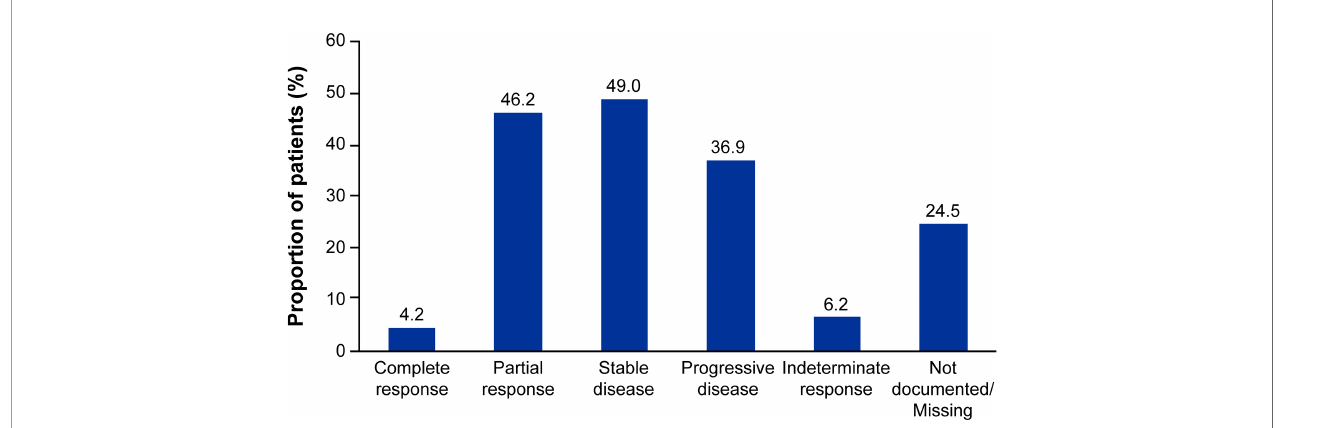
FIGURE 3 | Patient response to fi rst-line axitinib plus pembrolizumab treatment. Responses are not mutually exclusive and represent patient responses throughout the entire follow-up